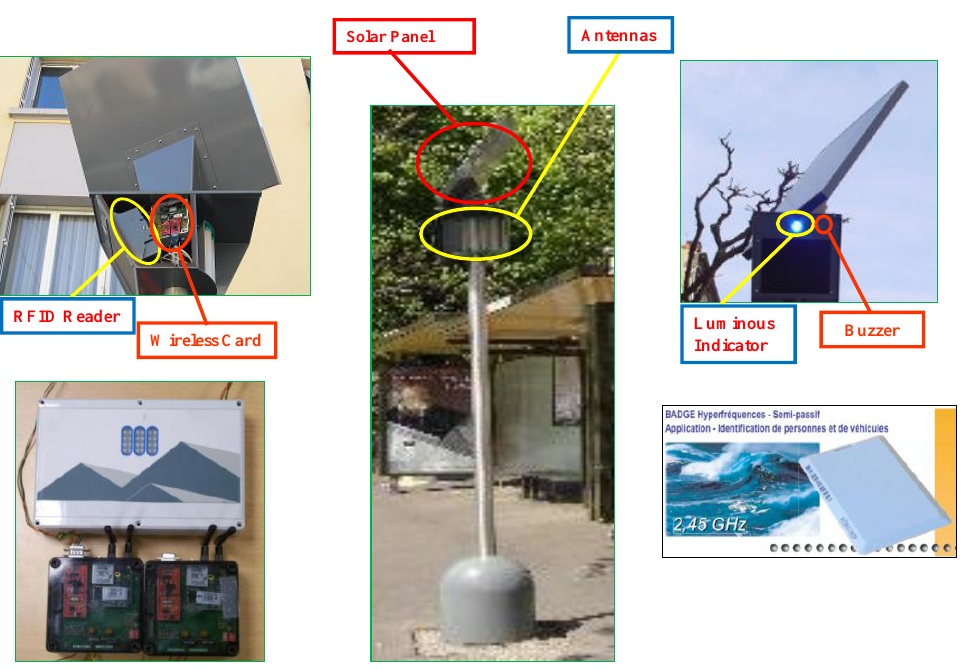
Figure 8. Station subsystem of Mobi+.